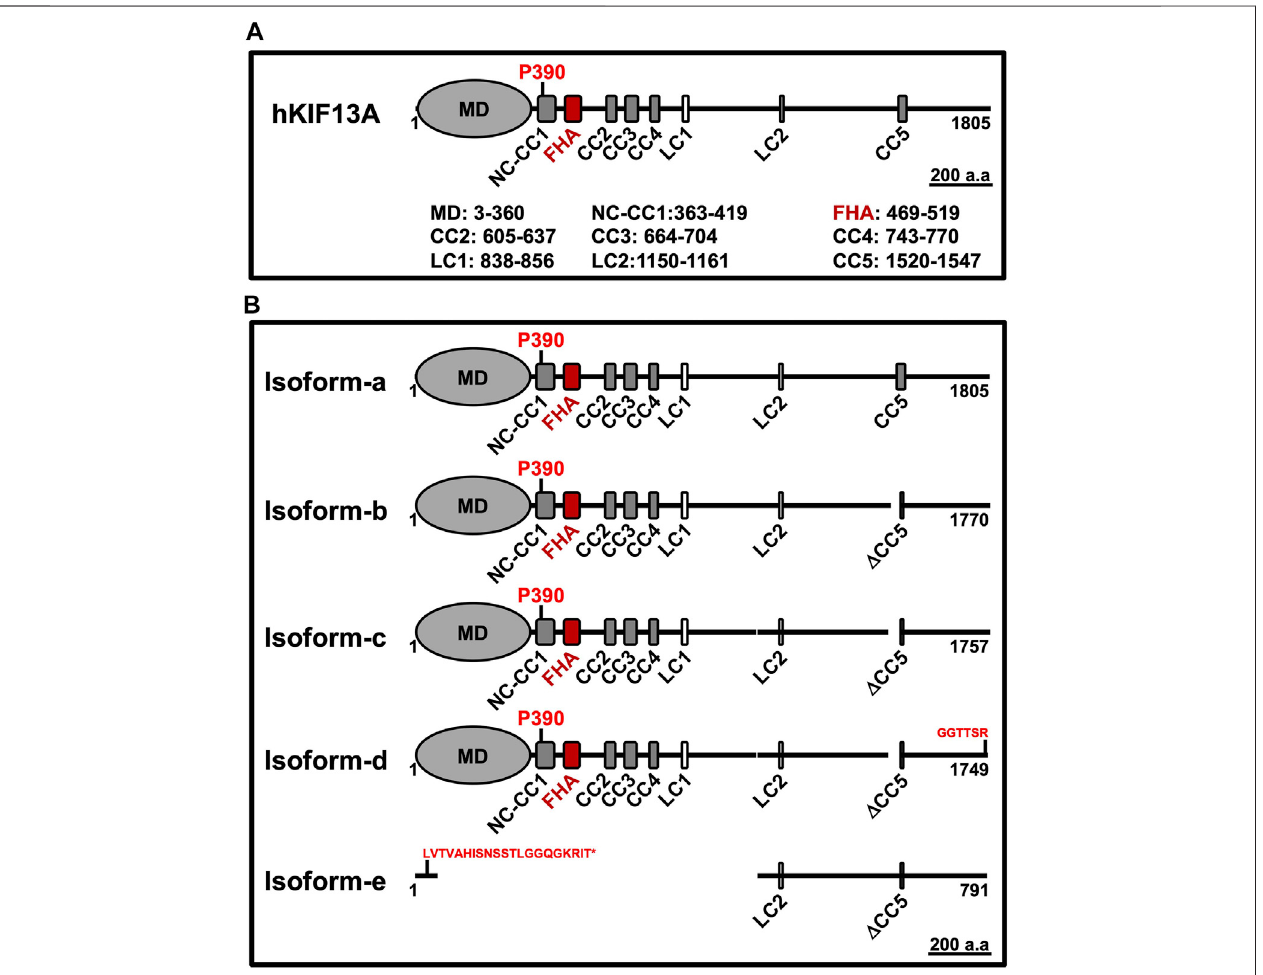
FIGURE 1 | A) Schematic representation of KIF13A domain structure. The longest monomeric human isoform contains one motor domain (MD), one forkhead- associated (FHA) domain, fi ve coiled-coil (CC) domains and two low complexity (LC) regions. After the MD, the neck coil (NC) region is merged with the CC1 domain.